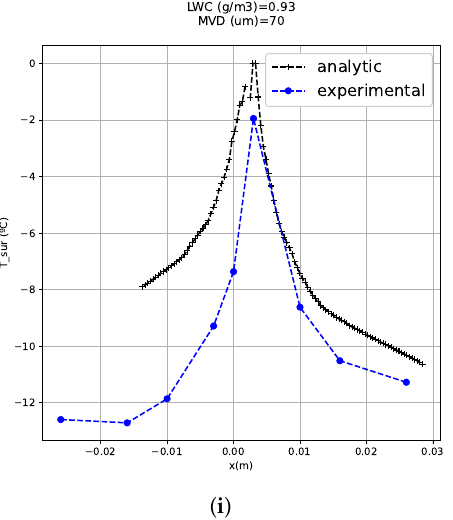
Figure 9. Rime test matrix. Angle of attack: − 5 ◦ . Test cases: ( a ) 10 ( b ) 13 ( c ) 16 ( d ) 11 ( e ) 14 ( f ) 17 ( g ) 12 ( h ) 15 ( i ) 18.